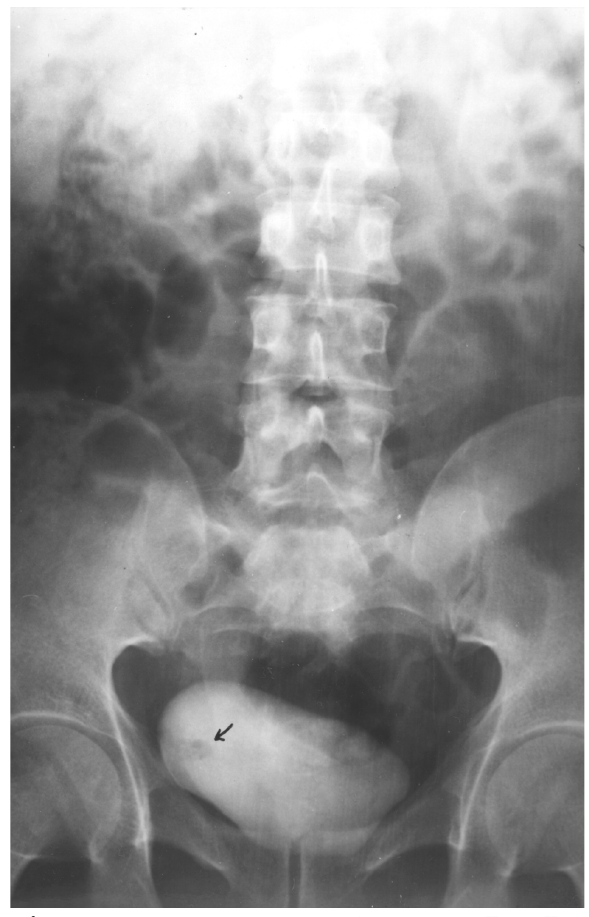
Figure 4 – An intravenous urogram showing a small solid tumor as filling defect in the right lateral wall of urinary